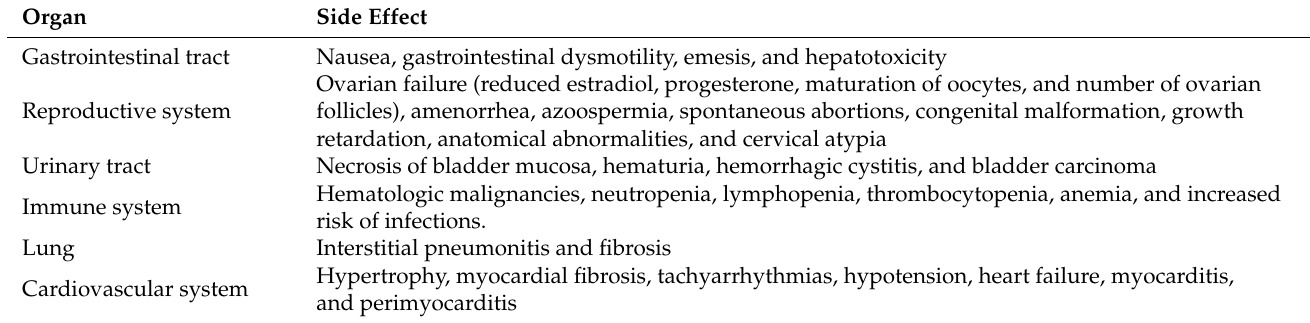
Table 4. Summary of Organ-Specific Side Effects of Cyclophosphamide